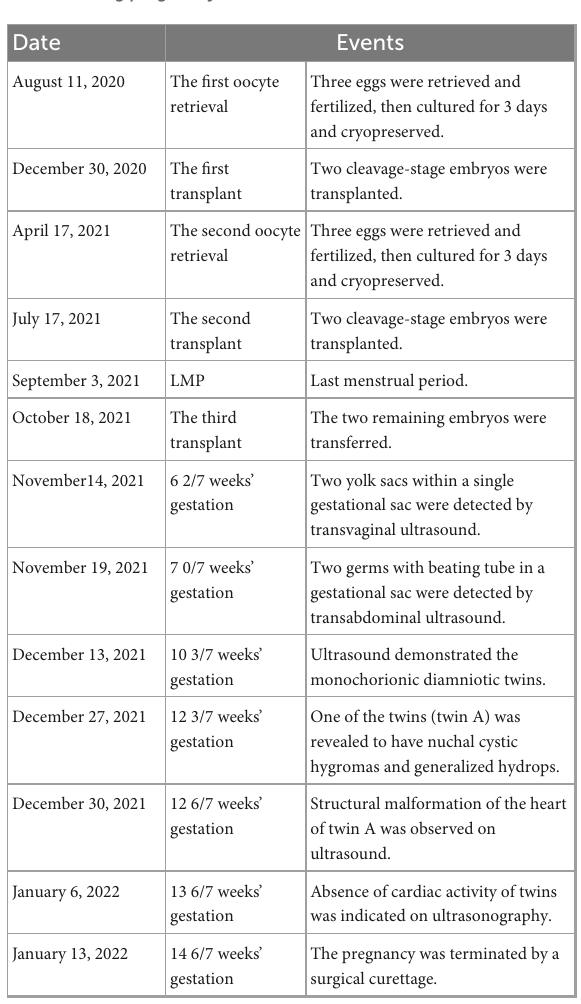
TABLE 1 A timeline of relevant events to the patient from conceiving to terminating